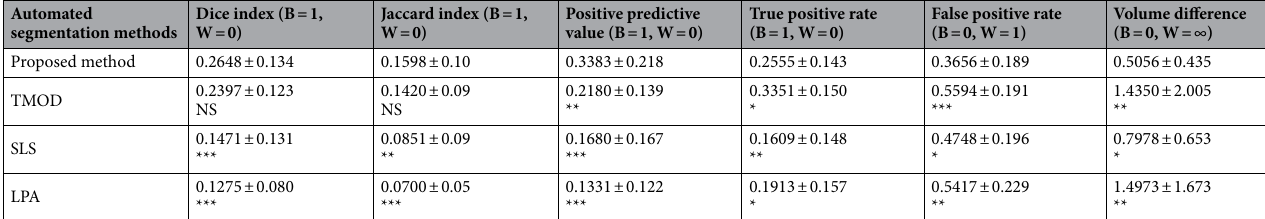
Table 2. Agreement measures for Dice index, Jacarrd index, positive predictive value, true positive rate, false positive rate, and volume difference between lesions segmented by the automated methods and a neuroradiologist for 25 subjects with mild WML loads. Dice index, Jaccard index, positive predictive value, true positive rate, false positive rate, and volume difference are presented as mean ± standard deviation. B indicates Best, and W is Worst. NS is not statistically significantly different compared with the proposed method (P > 0.05); * is significant at P ≤ 0.05; ** is significant at P ≤ 0.01, and *** is significant at P ≤ 0.001. All paired t-tests were Bonferroni corrected for four